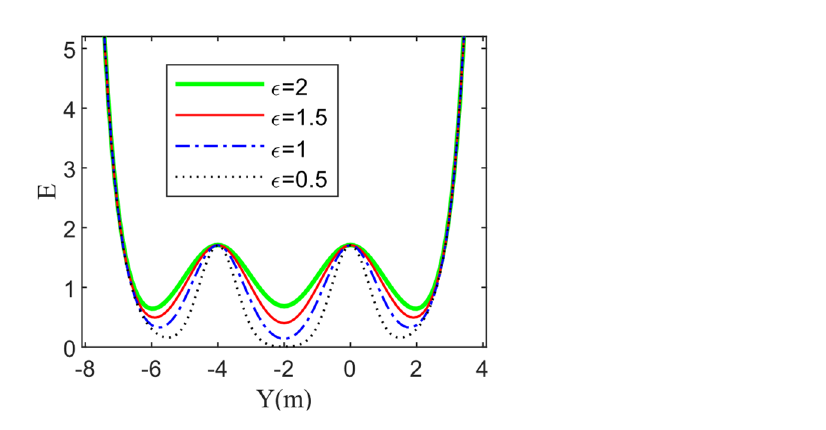
Figure 5. Road risk field: ( a ) 3D map of risk field; ( b ) A cross-sectional view along the Y-axis.